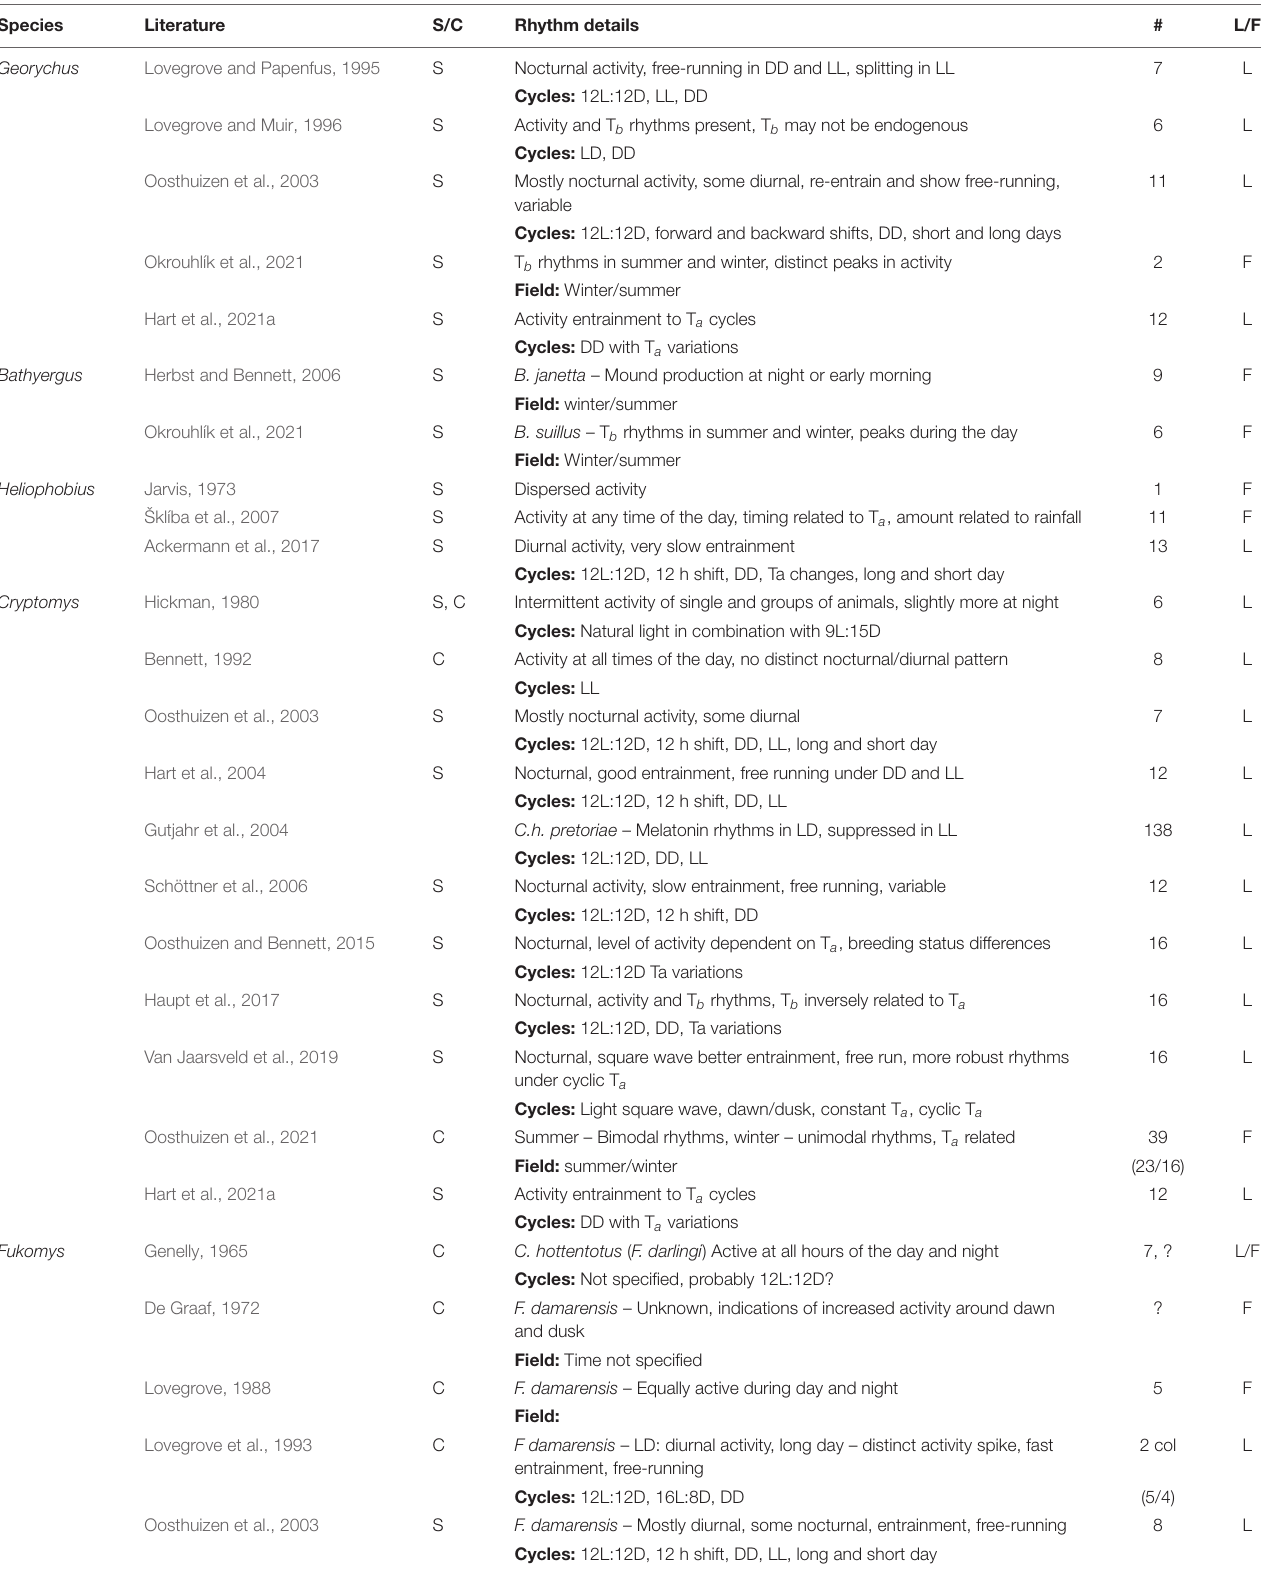
TABLE 1 | A summary of the literature on daily rhythms of African mole-rats. Species Literature S/C Rhythm details #